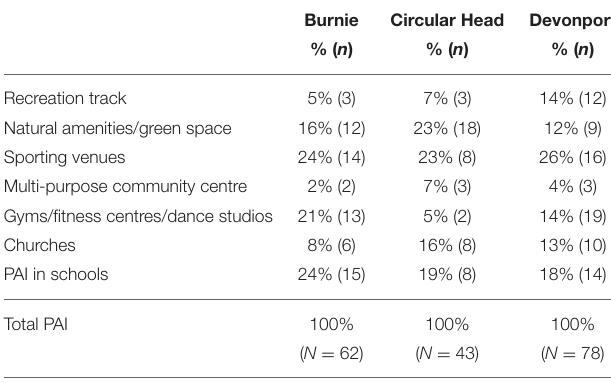
TABLE 1 | Proportion of physical activity infrastructure (PAI) in Burnie, Circular Head, and Devonport.